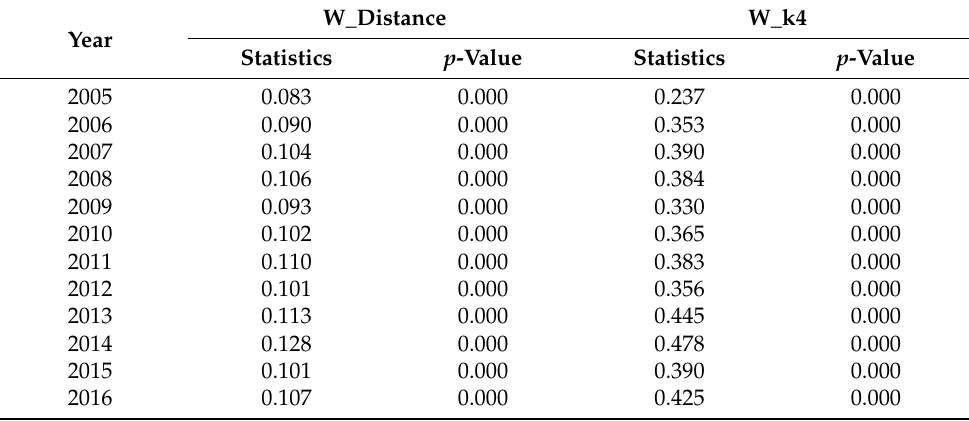
Table 9. Global Moran’s I value under the W_distance and